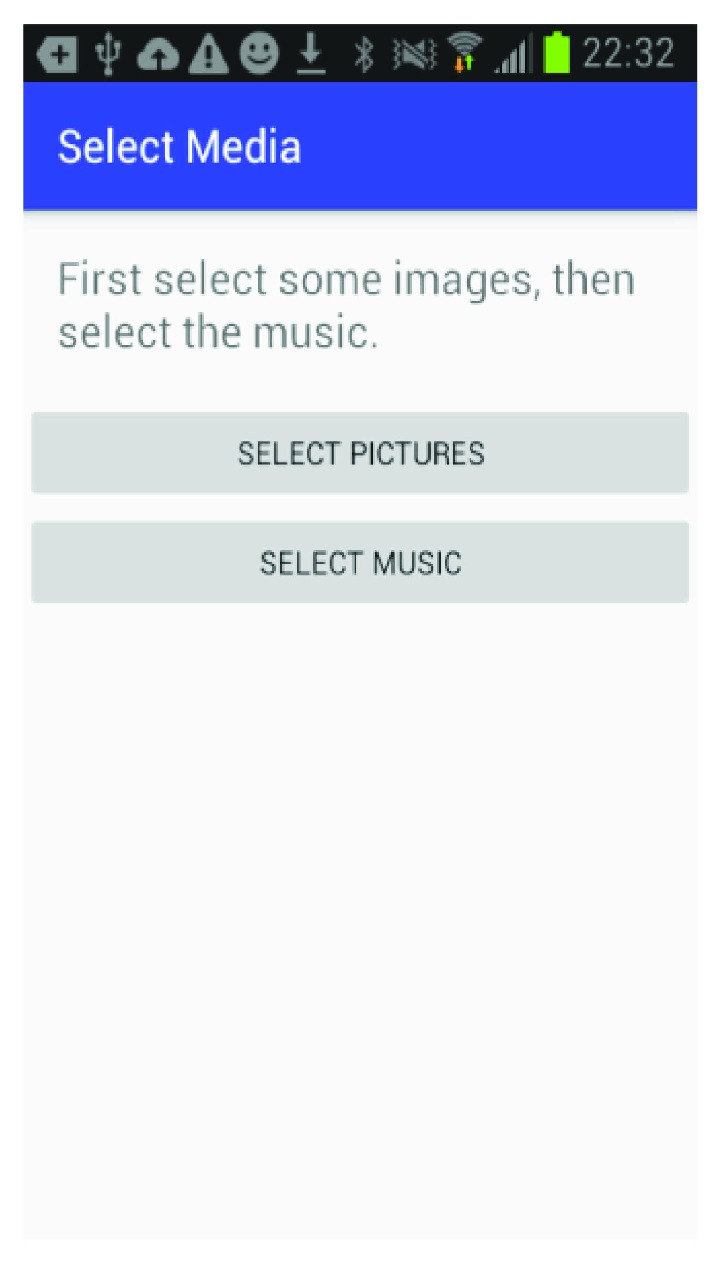
Media selection.